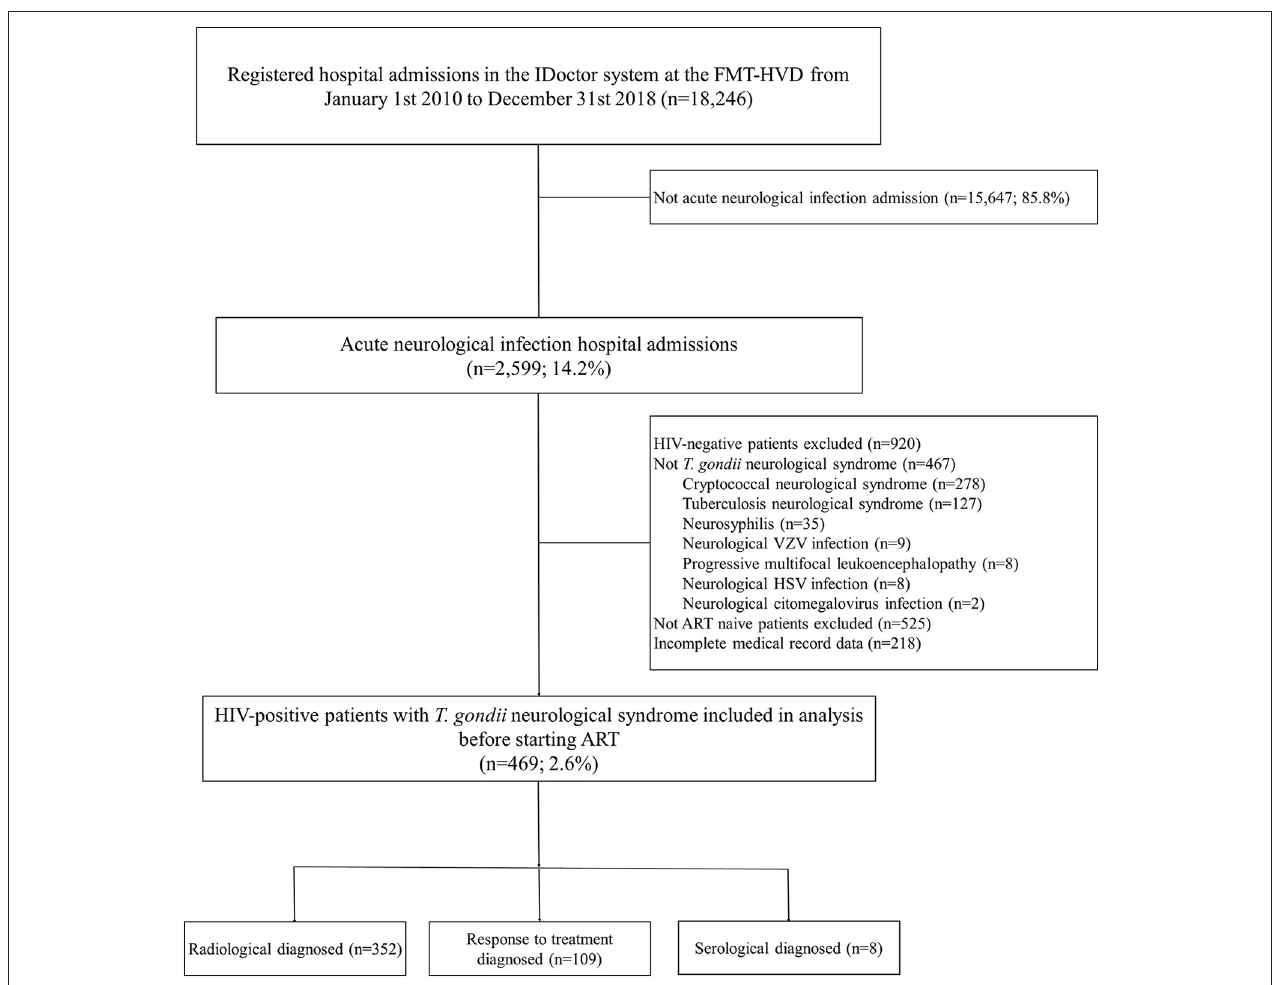
FIGURE 1 | Study flowchart of inclusion of ART-naïve hospitalized patients co-infected with HIV and T. gondii